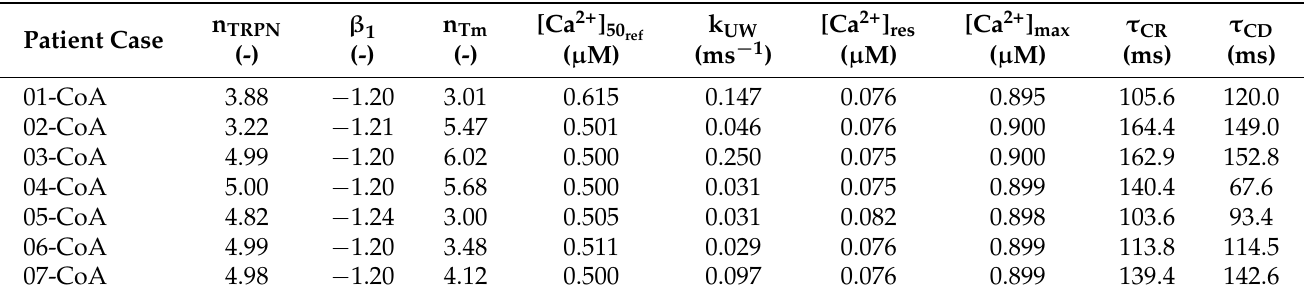
Table A7. Estimated parameter values of the personalised Land model and the personalised Rice model for each patient case.